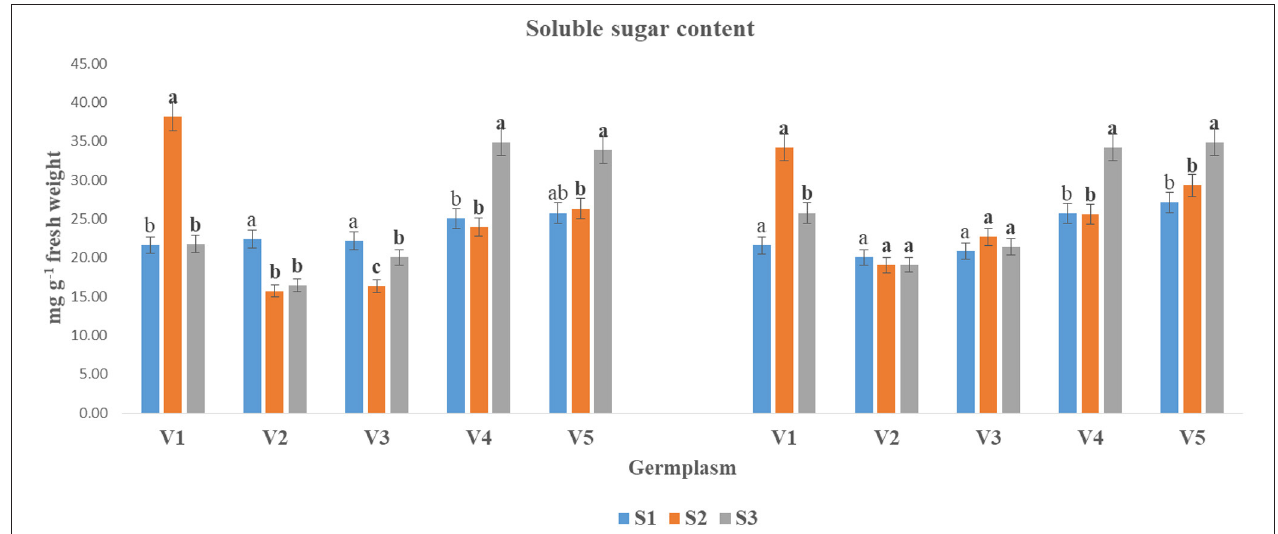
FIGURE 1 | The SS content (mg g − 1 fresh weight) at mid-flowering stage in the top leaf of mustard varieties sown at three different dates during rabi 2017–2018 and 2018–2019. Different date of sowing represented as S1 timely sown (30 October), S2 late sown (15 November) and S3 very late sown (30 November); Varieties symbolize with: V1, PM 25; V2, PM 26; V3, BPR-541-4; V4, RH-406; and V5, Urvashi, respectively. The mean value ± p ≤ 0.05 error bar data were presented in the figure and different alphabetical letters indicate the significant difference for each variety under different date of sowing ( p ≤ 0.05).